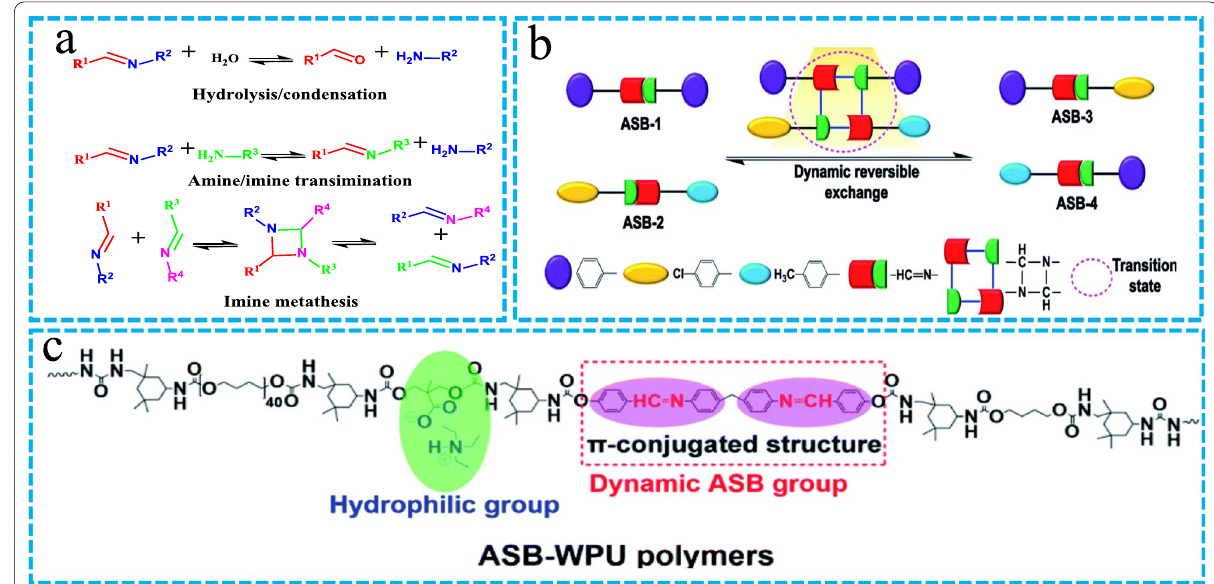
Fig. 5 a Reversible reactions involving imines: hydrolysis/condensation, amine-imine transimina-tion reation and imine metathesis [55–57]. b Shematic diagram of the imine exchange reactions of ASB bonds under visible light. c Chemical structure of ASB-WPU. Reprinted with